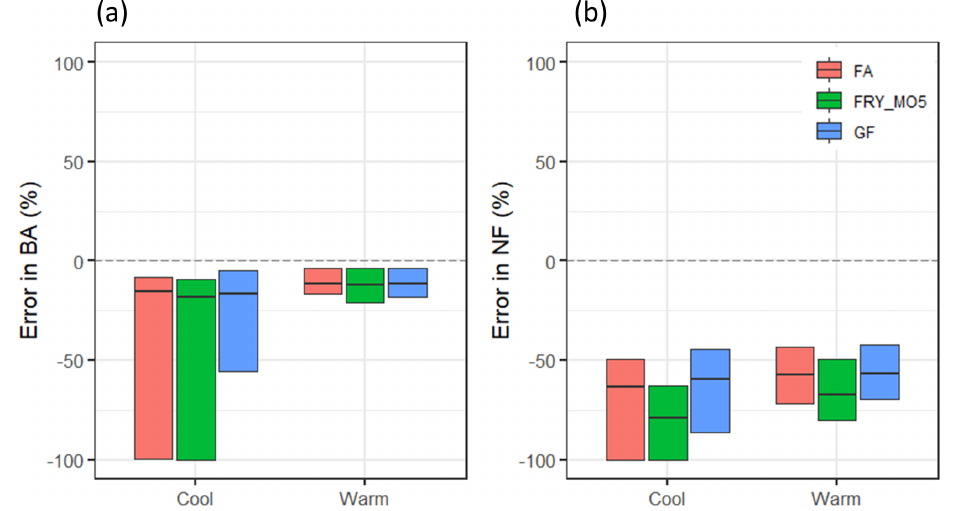
Figure 4. (a) Median and interquartile range of the seasonal error ( ε ) observed each year for burned area and (b) number of fires in each RSD for all fires > 1ha in the studied area. Cool season from November to April and warm season from May to October. Dashed lines represent the perfect agreement between the